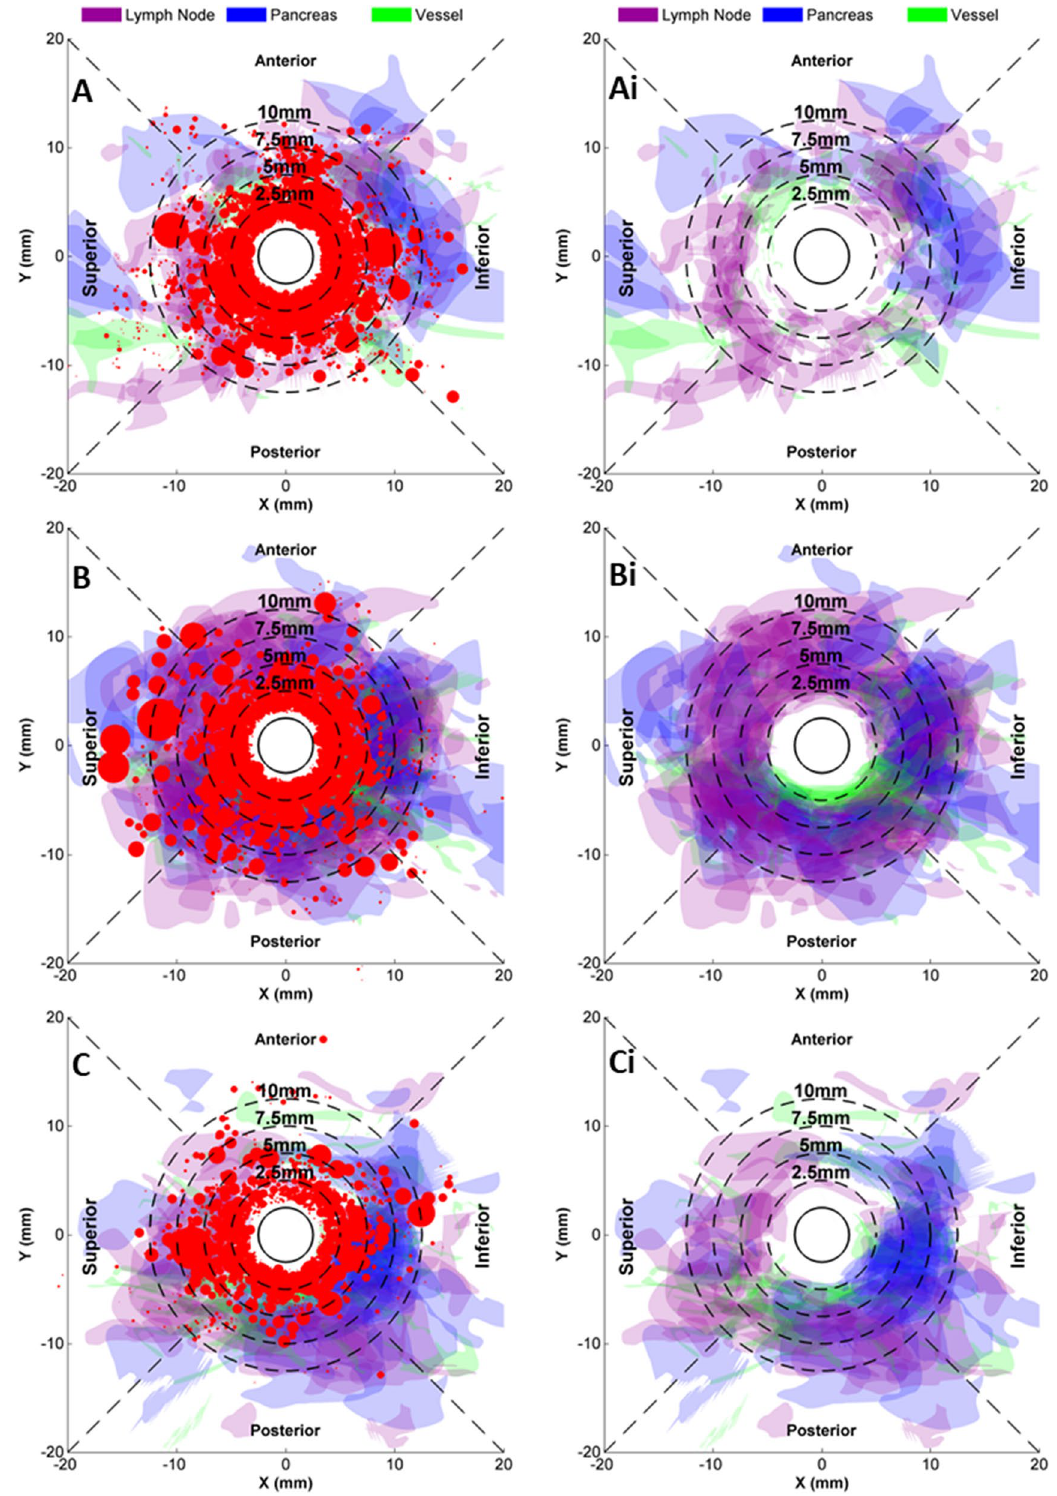
Figure 3. Periarterial CHA microanatomy varies with distance from aortic ostium and with orientation. Standardized composite microanatomy maps of the CHA classified by longitudinal location, ( A , Ai ) proximal, ( B , Bi ) middle and ( C , Bi ) distal, and depicted for each of the four quadrants. Three sequential views are presented per segment, from proximal to distal (arrow) with each depicting areas associated with nerves (red) lymph nodes (purple), pancreas (blue) and adjacent blood vessels (green). ( Ai – Ci ) Depict the surrounding anatomies without the obscuring nerves. Greater color intensities imply greater local lymph node, pancreas, or vessel composite